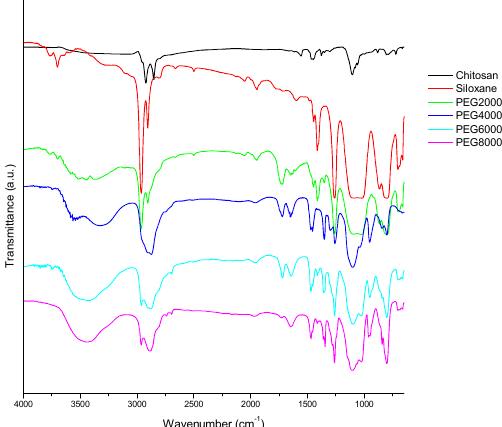
Figure 1. FTIR (Fourier Transform Infrared Spectroscopy) spectrum of chitosan derivative polyester; Chitosan: raw material; Siloxane: raw material; PEG2000: Chitosan/siloxane polyesters with PEG 2000 chain lengths